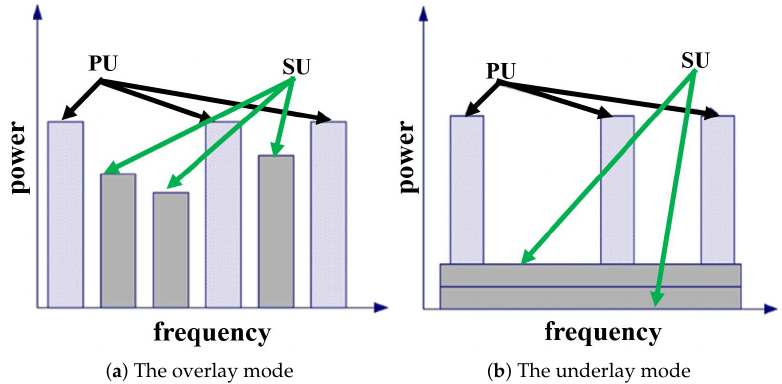
Figure 1. The overlay and underlay modes of cognitive radio networks